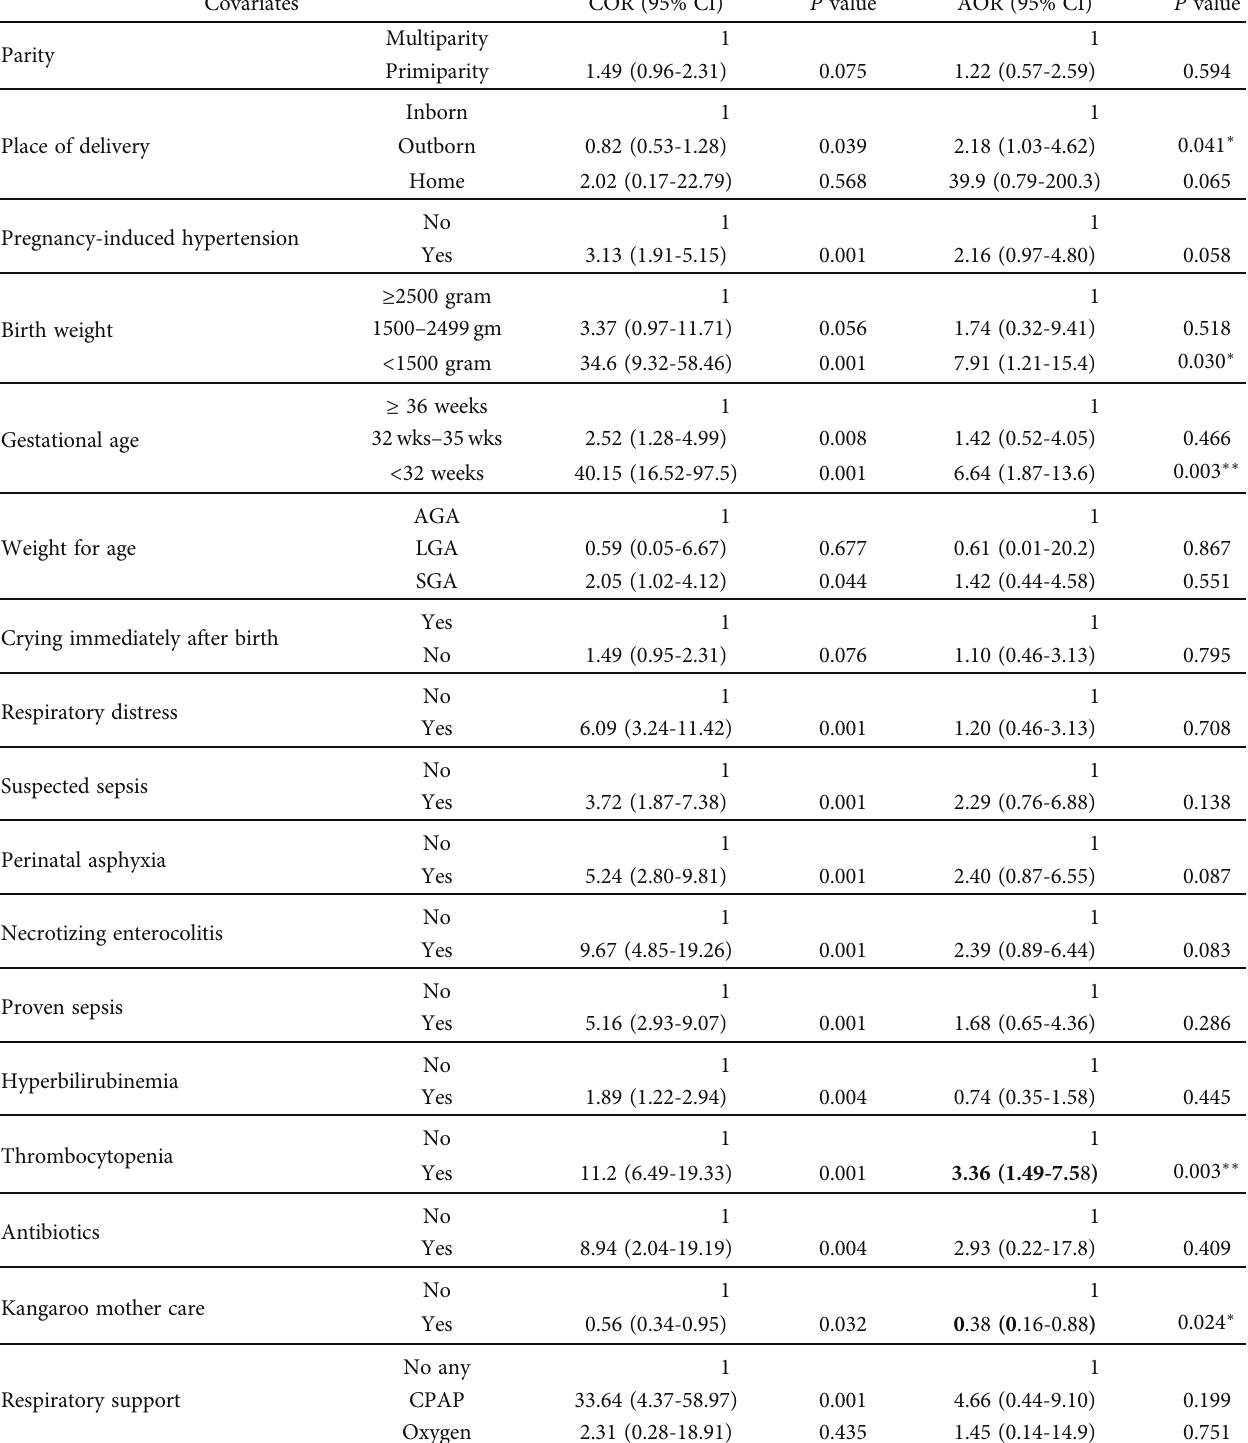
Table 3: Bivariable and multivariable logistics regression analysis results of hypothermic preterm babies who were admitted at neonatal intensive care units of Addis Ababa public hospitals, Ethiopia, 2022 [ n = 311